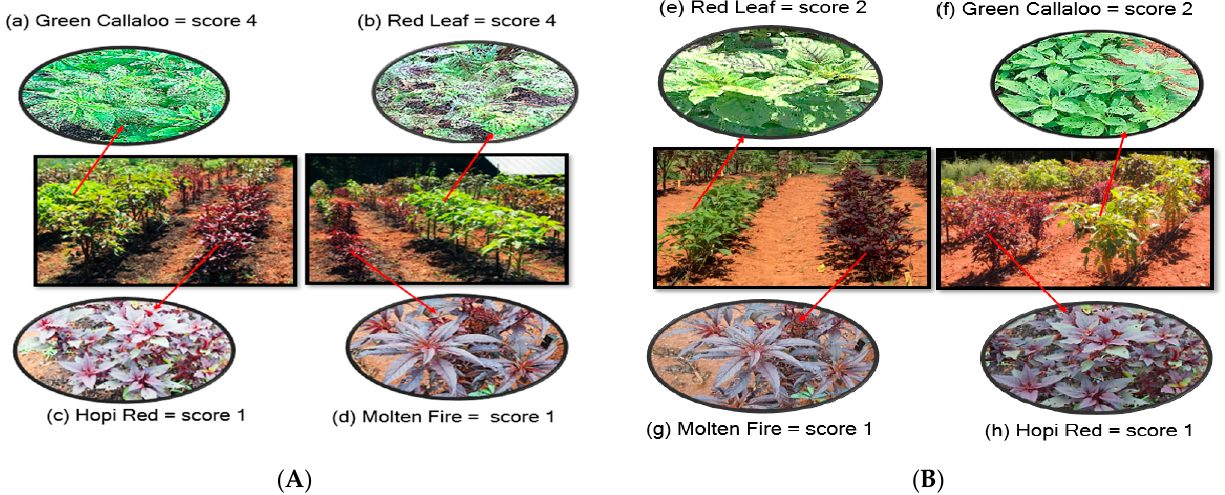
Figure 3. Leaf damage on amaranth varieties on plots with mulch ( A ) (high damage, a and b; low damage, c and d); and on plots with no-mulch ( B ) (high damage, e and f; low damage, g and h).